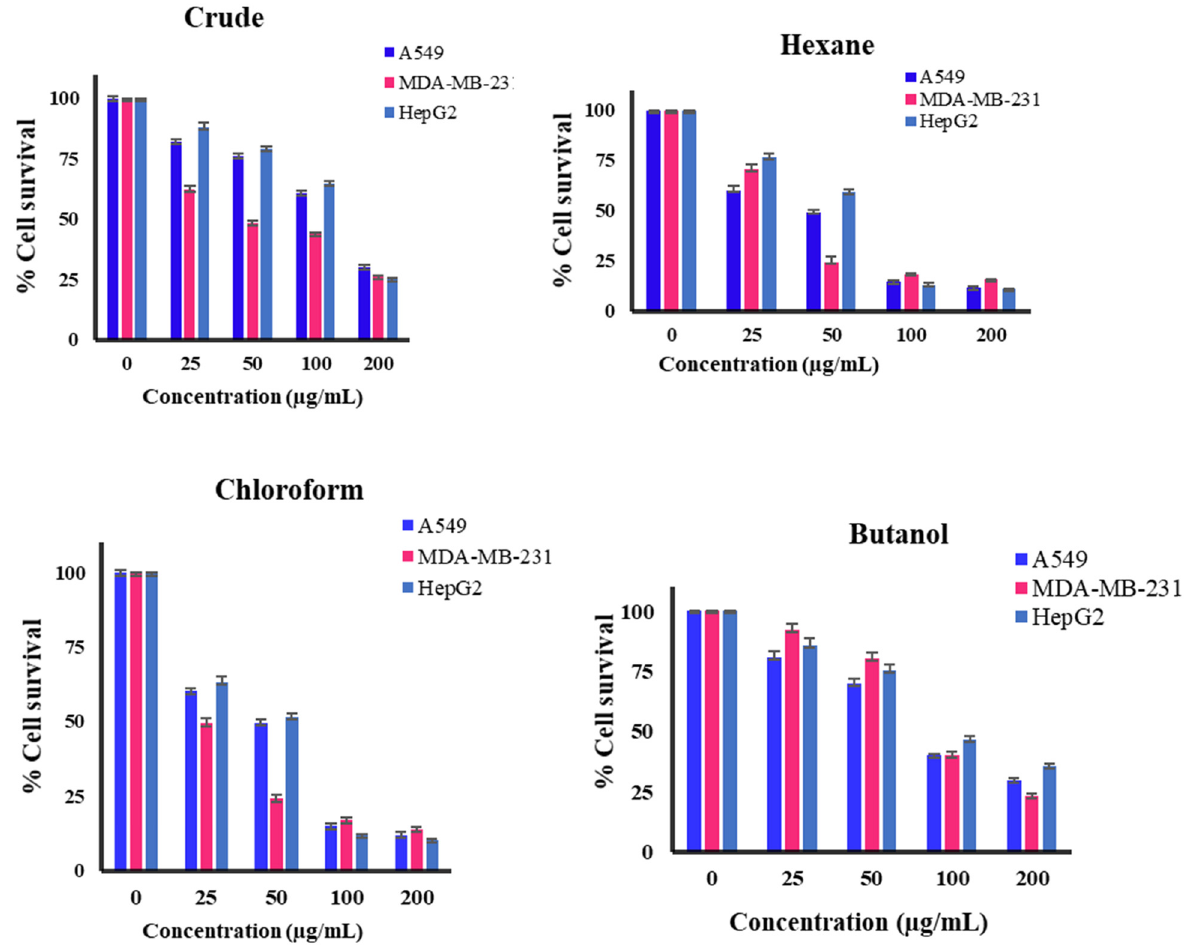
Figure 4: Cytotoxic activity of D. viscosa fractions against various cancer